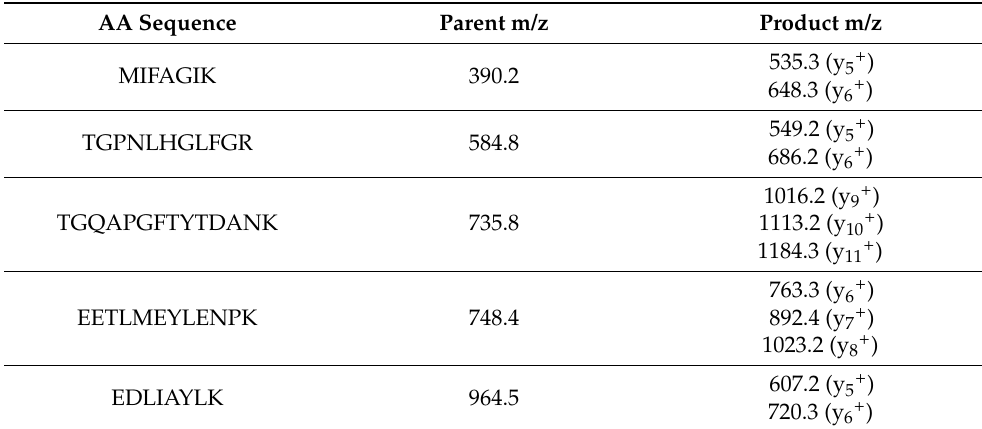
Table 1. Tryptic peptides and SRM